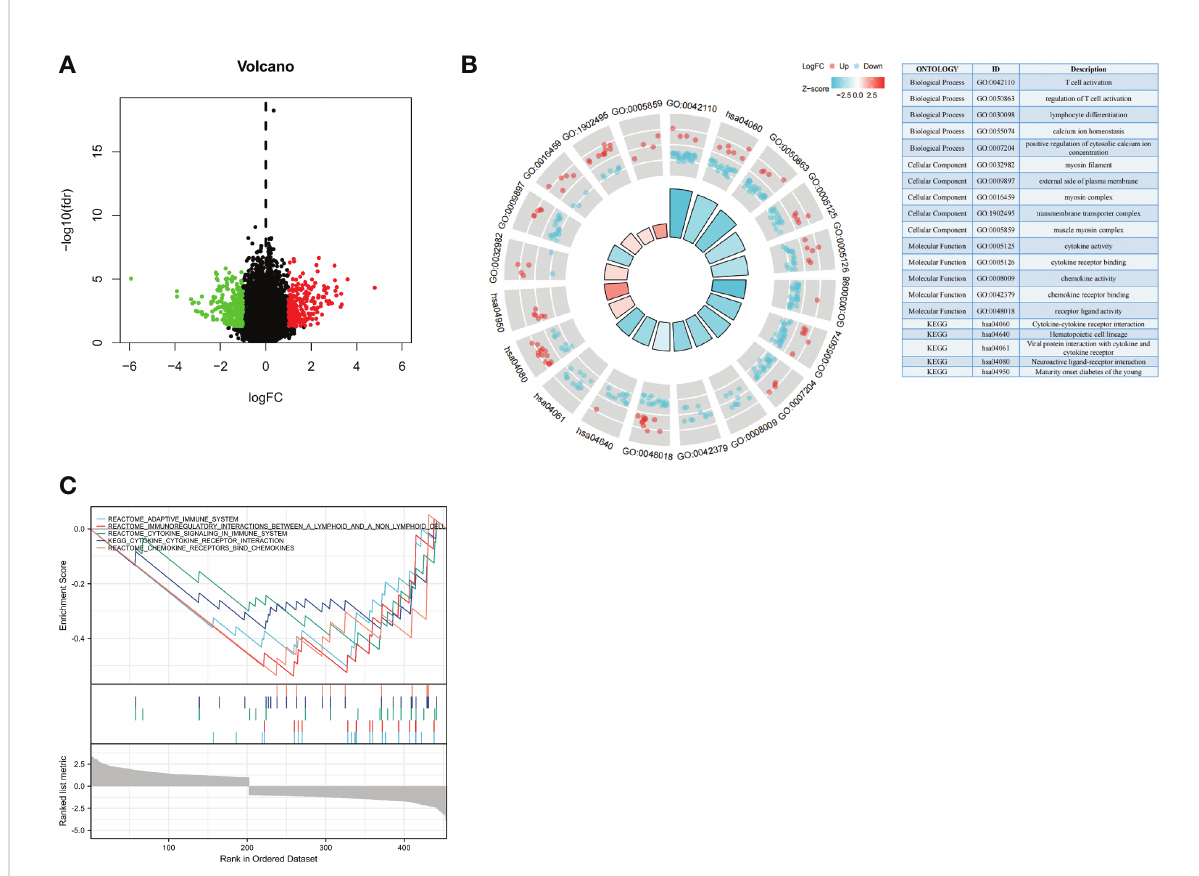
FIGURE 7 Biological functions of NBPF1 in ACC. (A) Volcano plot showing differentially expressed genes of high- and low- NBPF1 expression groups. (B) GO/KEGG enrichment analysis. (C) GSEA enrichment